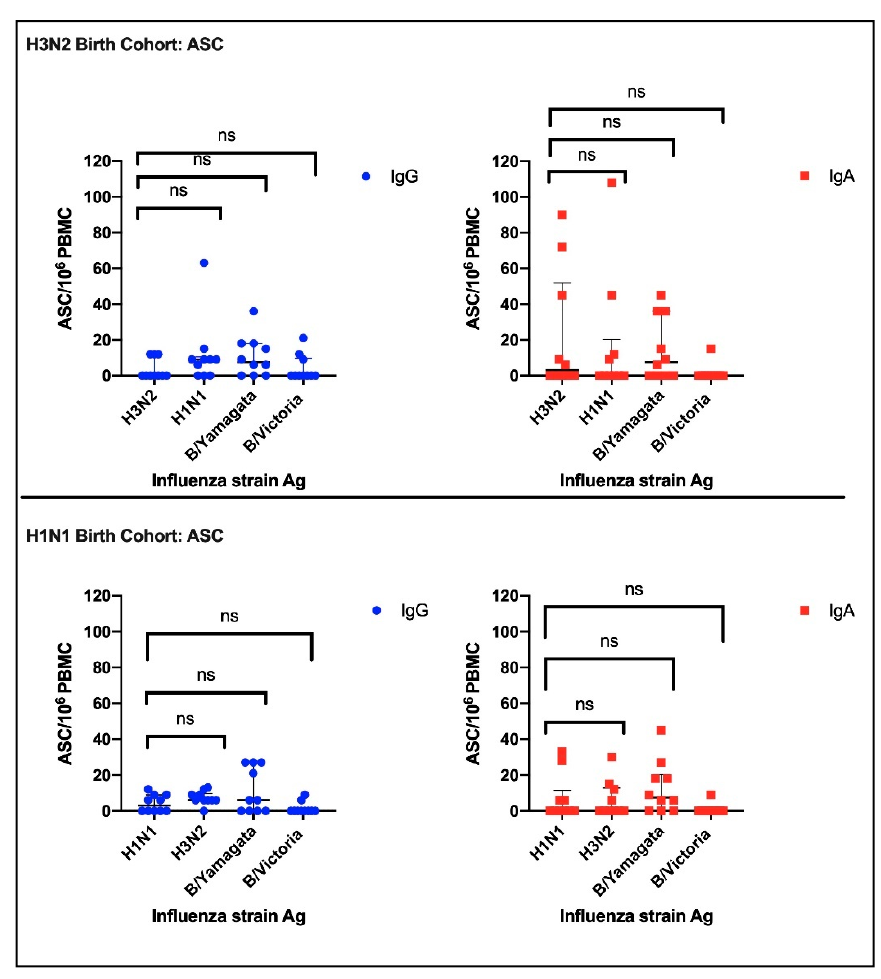
Figure 1. The top panel shows the antibody-secreting cells (ASC) for the H3N2 birth cohort, and the bottom panel shows the ASC for the H1N1 birth cohort. Blue dots are the numbers of antigen-specific IgG-secreting B cells measured for each participant, and red dots are IgA. The black error bars denote median and IQR, and “ns” denotes a non-significant difference.